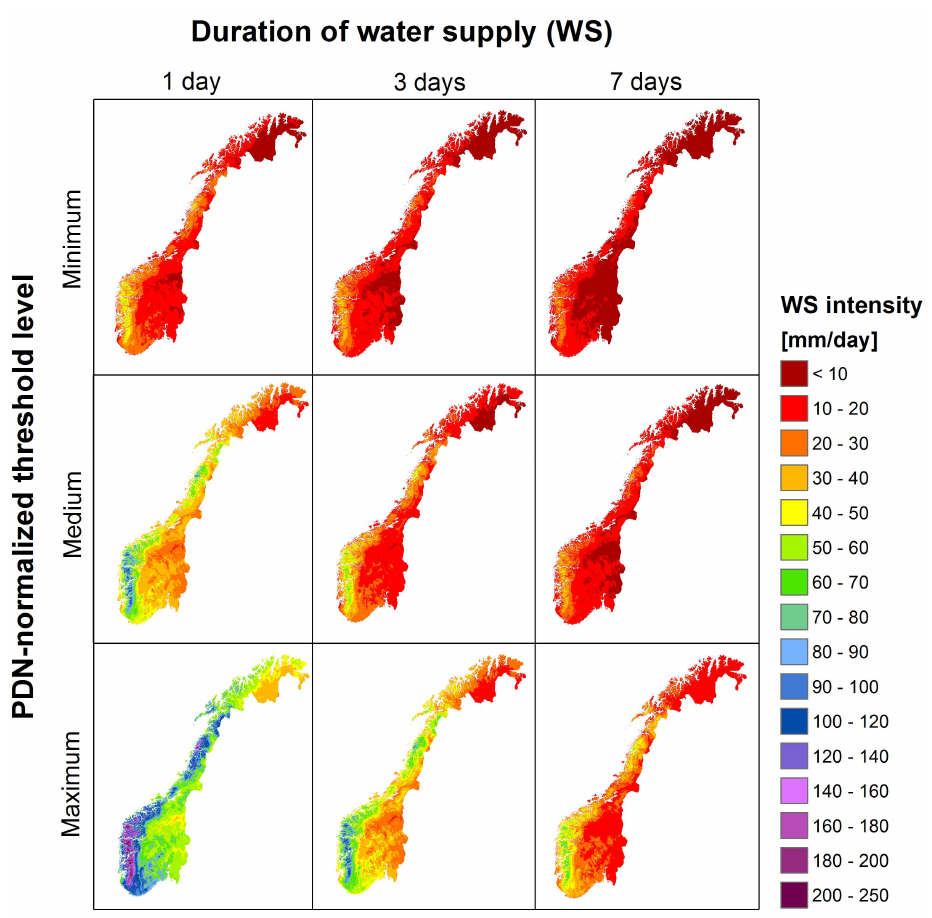
Fig. 6. Spatial distribution of the water supply (WS) intensity needed for debris flow initiation after 1 day, 3 days and 7 days of water supply according to the normalized minimum, medium and maximum ID